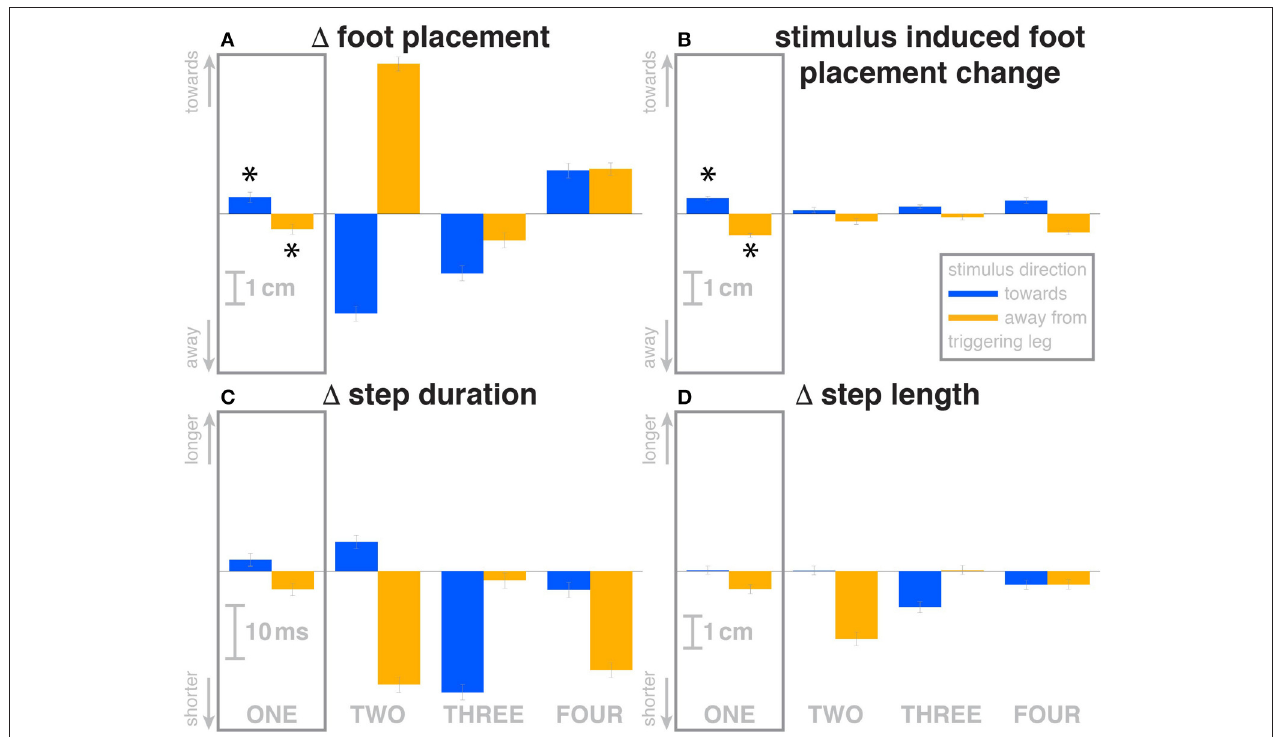
FIGURE 3 | Changes in response to the visual stimulus in the medial-lateral foot placement (A) , step duration (C) and step length (D) , and the model-based estimate of the component due to the visual perturbation alone (B) . The baseline represents the average of the control steps. Shown are data for the four steps following each visual perturbation, with the first step marked for clarity. Blue bars correspond to fall stimuli toward the triggering leg, orange bars to fall stimuli away from the triggering leg. Asterisks indicate statistically significant difference from zero (see Table 3 ). Lack of marks indicate that no hypothesis was statistically